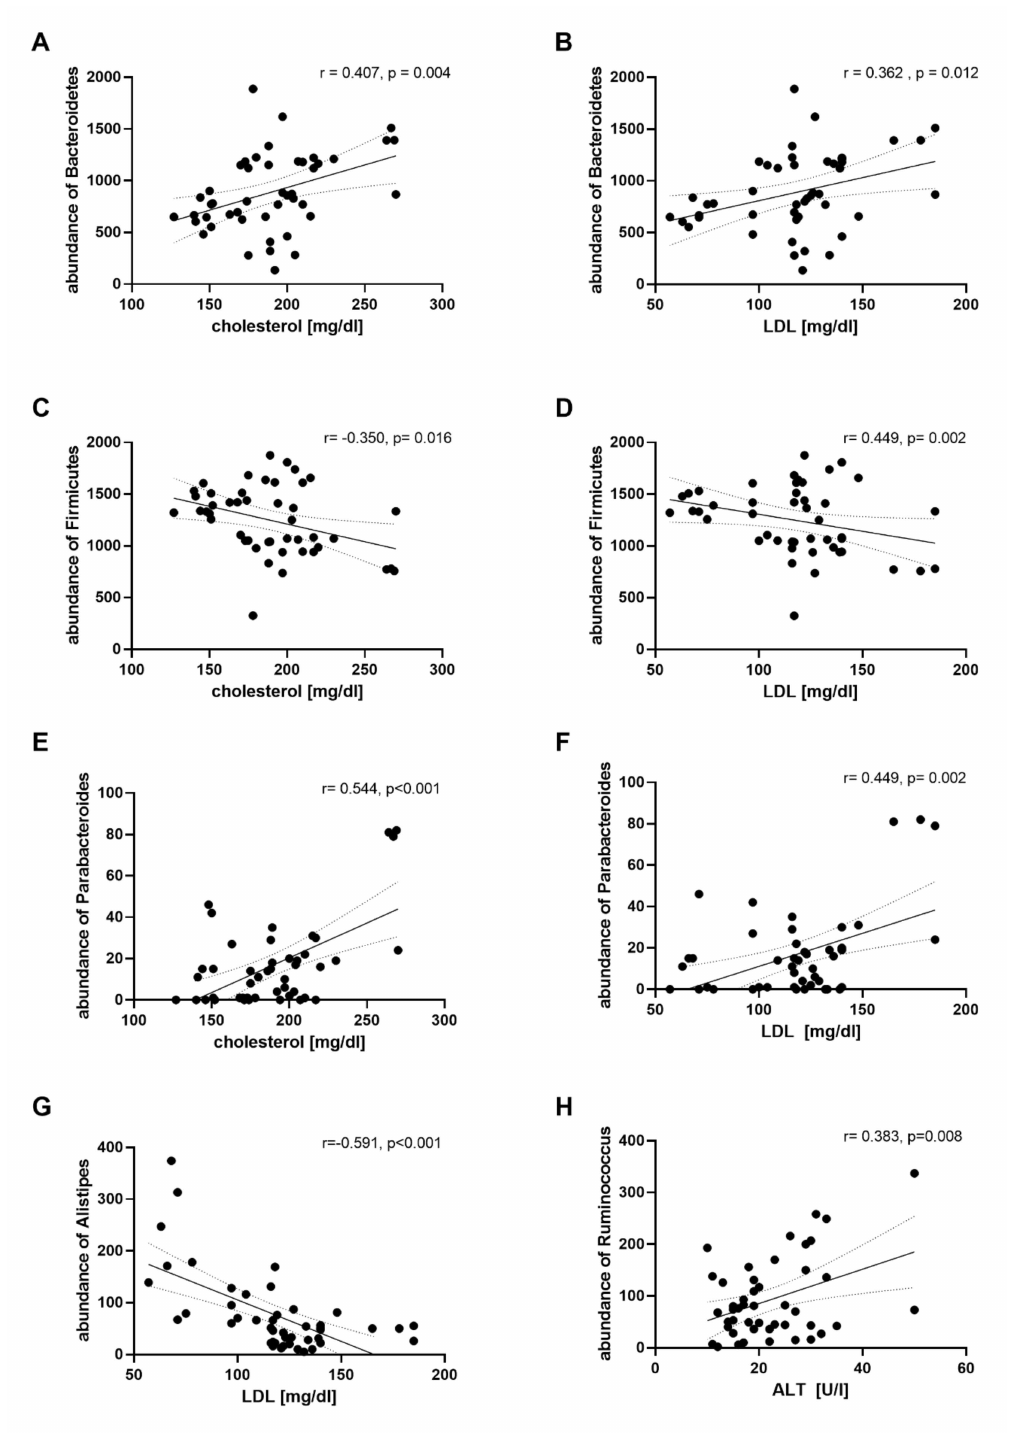
Figure 5. Abundances of specific phyla and genera that correlate with plasma lipid parameters. Bacteroidetes abundance vs. cholesterol ( A ) and LDL level ( B ), Firmicutes abundance vs. cholesterol ( C ) and LDL level ( D ), Parabacteroides abundance vs. cholesterol ( E ) and LDL level ( F ). Alistipes abundance vs. LDL level ( G ), Ruminococcus abundance vs. ALT level ( H ). Pearson’s correlation analysis is shown. Each dot represents a related pair of values from the study subjects. LDL, low density lipoprotein; ALT, alanine